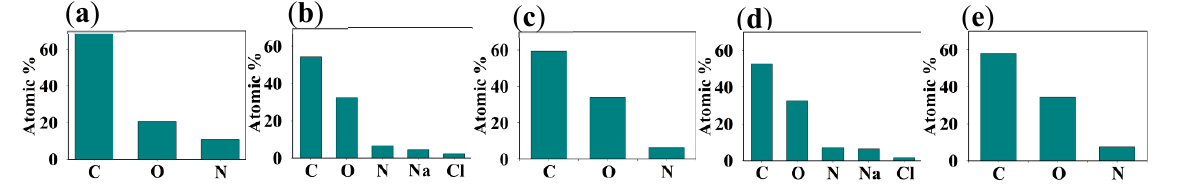
Figure 9. Quantitative analysis of elemental composition on the surface of ( a ) virgin, ( b ) P1, ( c ) P1- clean, ( d ) P2, and ( e ) P2-clean membranes.